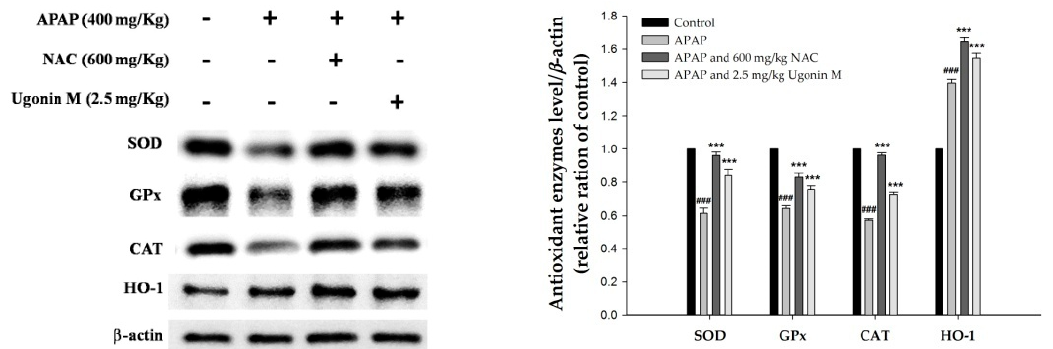
Figure 5. The effects of Ugonin M towards antioxidant enzymes expression (superoxide dismutase (SOD), glutathione peroxidase (GPx), catalase (CAT), and hemeoxygenase-1 (HO-1)) in liver tissues. Data are expressed as M ± SD ; n = 3